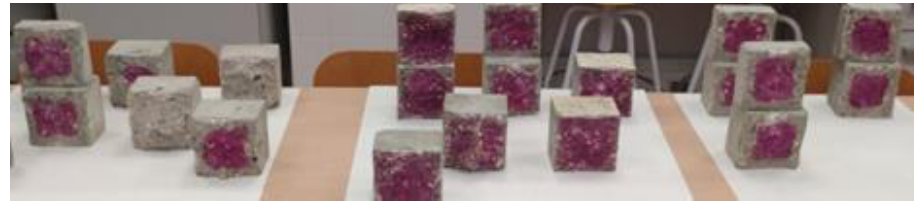
Figure 11. Carbonated SCC probes.